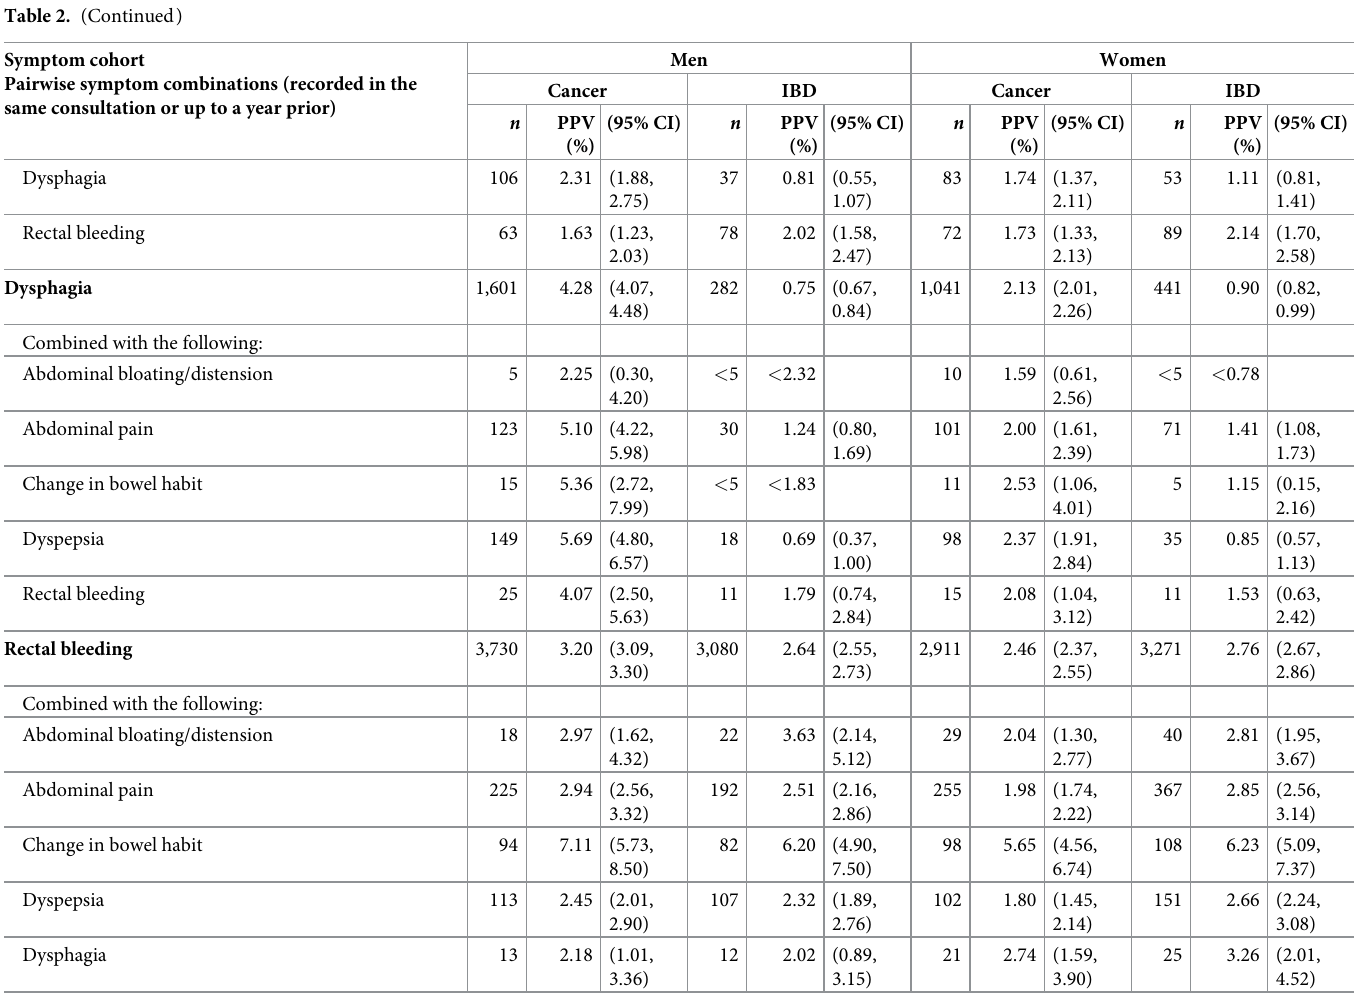
men, PPVs for cancer were higher than those for IBD for all abdominal symptoms (e.g., abdominal pain: 1.77% versus 1.17%; Table 2 ). In contrast, in women, the risk of cancer and the risk of IBD tended to be similar; further, for change in bowel habit and for rectal bleeding, the risk of IBD exceeded that for cancer. Across the 6 symptom cohorts, 1.41% (95% CI: 1.36% to 1.46%) to 4.64% (4.45% to 4.84%) of men and 1.03% (0.99% to 1.07%) to 2.46% (2.37% to 2.55%) of women were diagnosed with cancer in the year following their index consultation. For each studied abdominal symptom, PPVs for cancer were higher in men than in women. Change in bowel habit, dysphagia, and rectal bleeding were the 3 symptoms with relatively higher PPVs for cancer (men: 4.68%, 4.28%, and 3.20%, respectively, and women: 2.57%, 2.13%, and 2.46%, respectively).